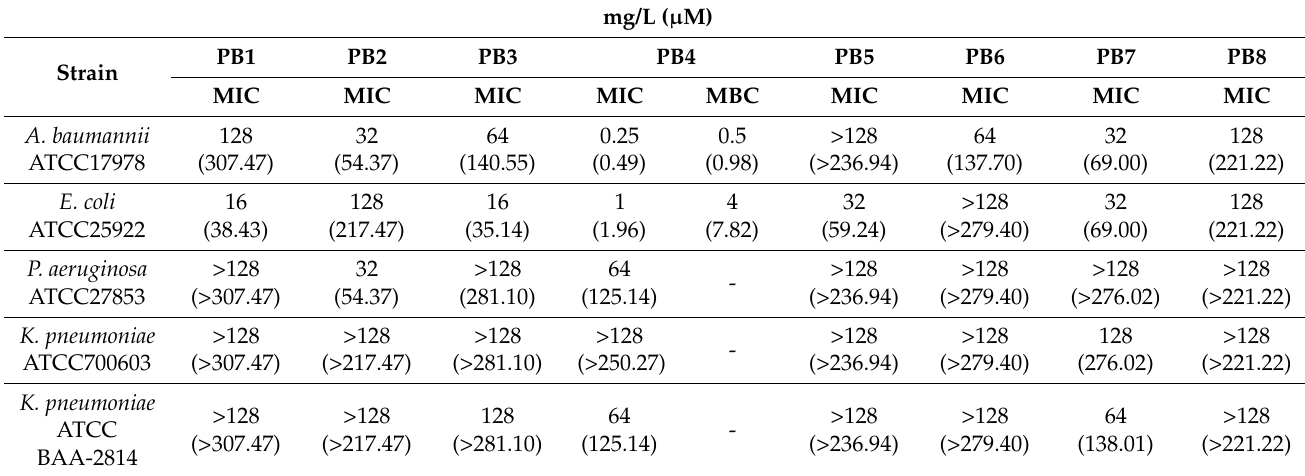
Table 2. MIC and MBC values for Gram-negative control